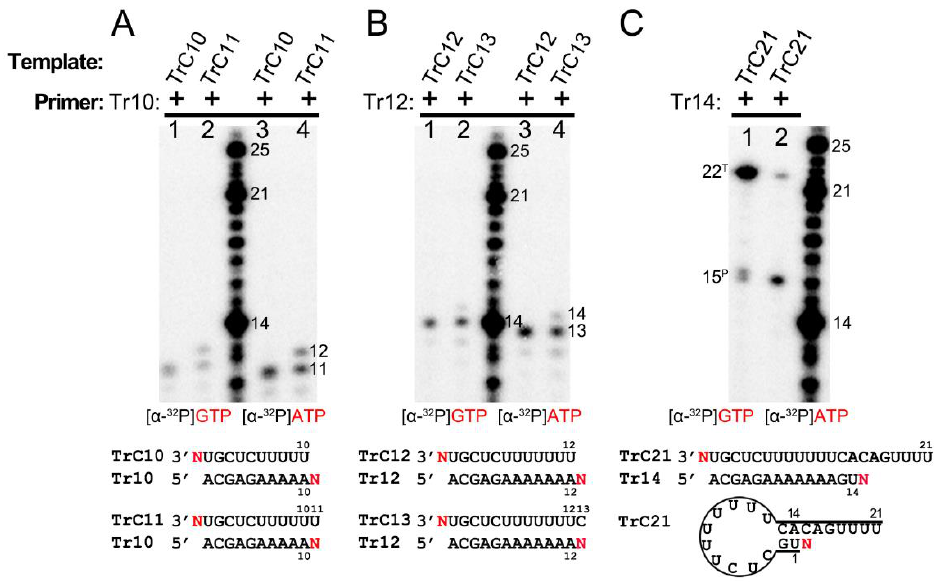
Figure 5. Primer-based terminal extension activity of RSV polymerase is NTP nonspecific. ( A ) Primer-based RNA terminal extension of template TrC10 and TrC11 with primer Tr10 in the presence of [ α - 32 P] GTP or [ α - 32 P] ATP. ( B ) Primer-based RNA terminal extension of template TrC12 and TrC13 with primer Tr12 in the presence of [ α - 32 P] GTP or [ α - 32 P] ATP. ( C ) Primer-based RNA terminal extension of template TrC21 with primer Tr14 in the presence of [ α - 32 P] GTP or [ α - 32 P] ATP. The superscript labels indicate the band is generated from primer ( P ) or template ( T ). ATP at 50 µ M with 5 µ Ci of [ α - 32 P] ATP and GTP at 50 µ M with 5 µ Ci of [ α - 32 P] GTP were used in the reaction mixtures as indicated. The products from [ α - 32 P] GTP are slightly larger than that from [ α - 32 P] ATP. Red N represents [ α - 32 P] ATP or [ α - 32 P] GTP. The red GTP and ATP indicate radiolabeled GTP and ATP,